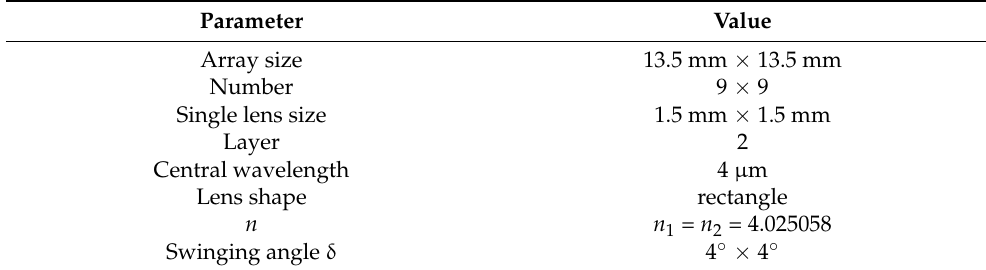
Table 1. Array system parameters.